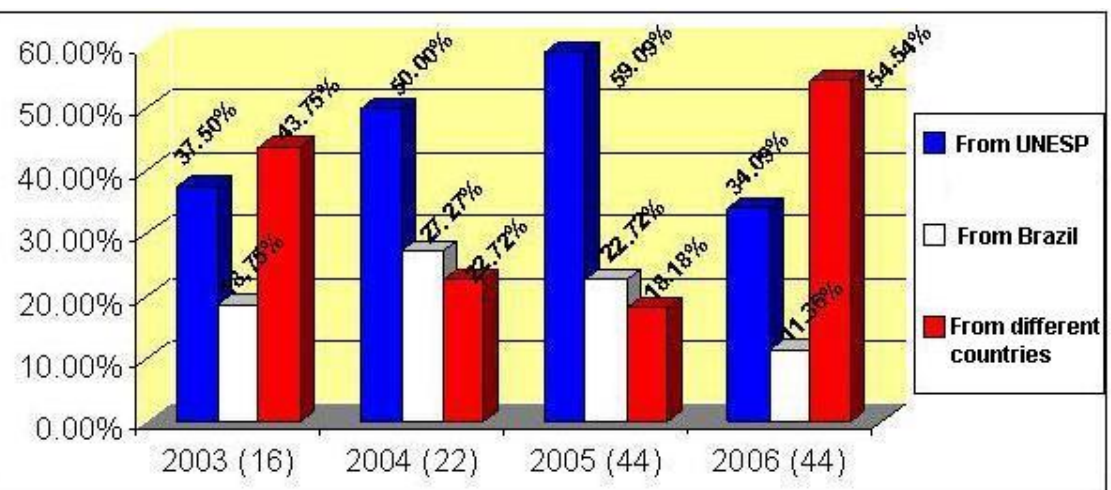
Figure 1: Frequency of papers published in The Journal of Venomous Animals and Toxins including Tropical Diseases from 2003 to